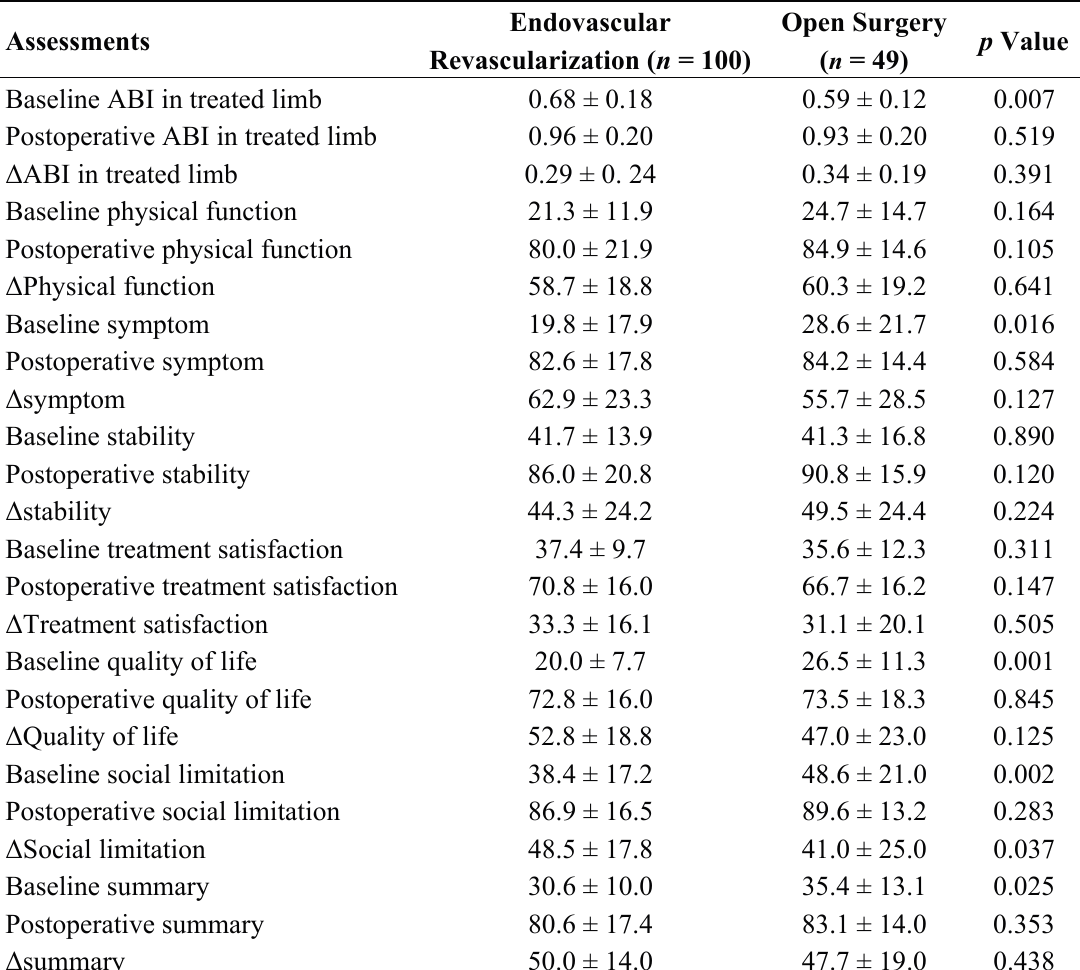
Table 3. Changes in PAQ scores and ABI following lower limb revascularization via endovascular or open surgery.